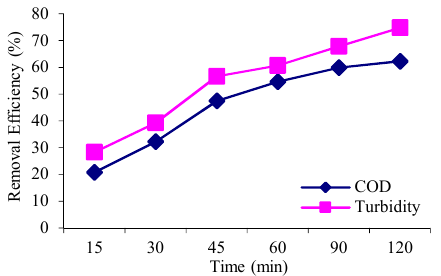
Fig. 8. Effect of contact time on COD removal and